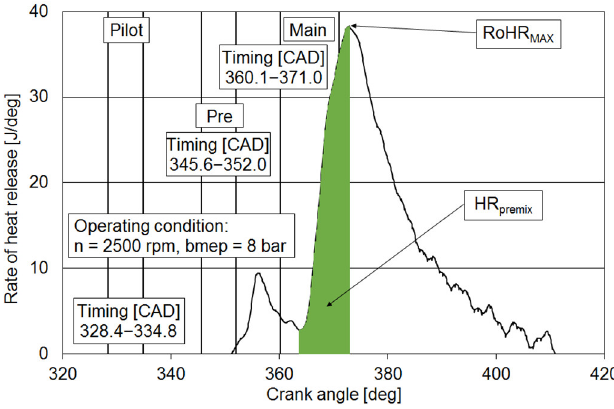
Figure 3. Example of the rate of heat release curve and related combustion parameters.